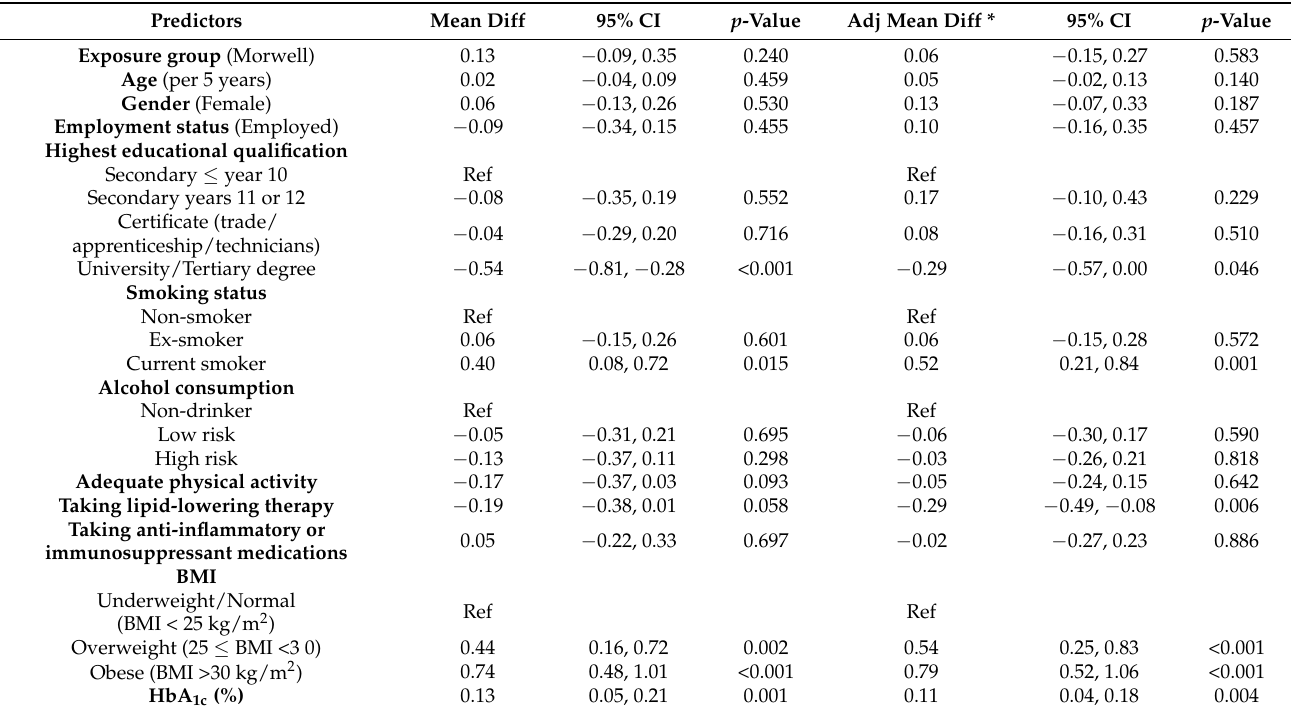
Table 4. Results of regression analysis for